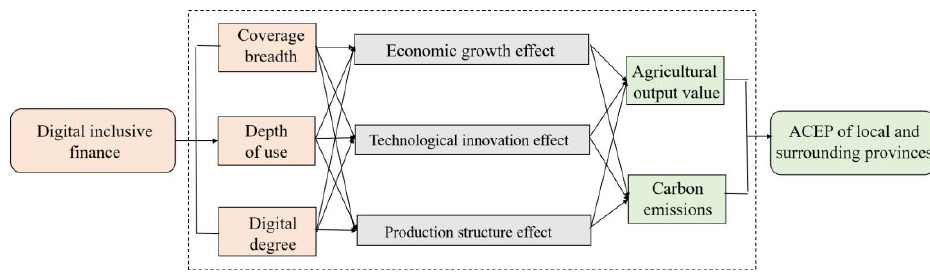
Figure 1. The mechanism of DIF on agricultural carbon emission performances.